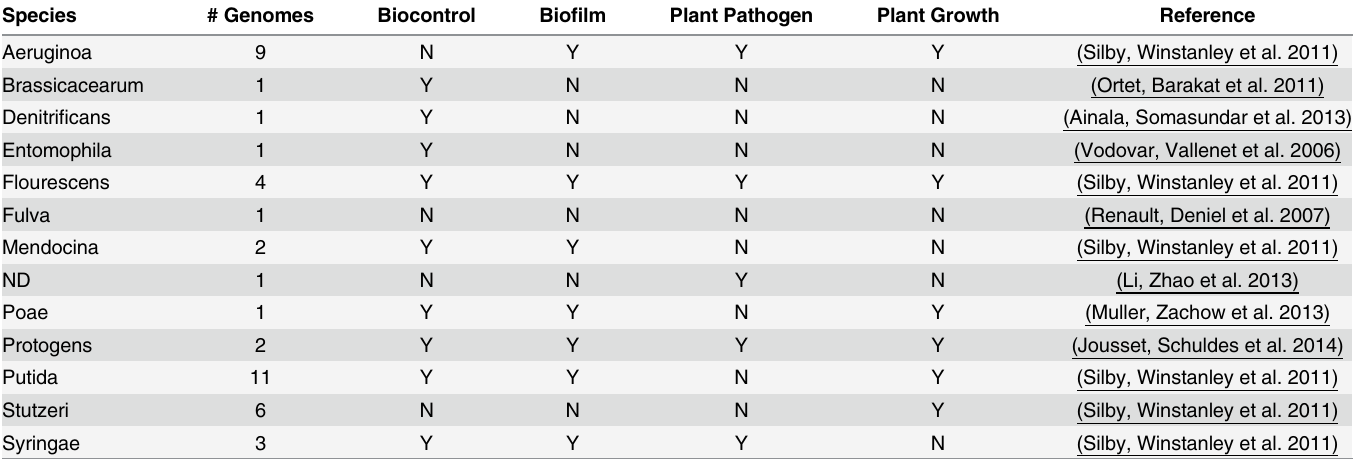
Table 1. Assigned Ecological Niche Classifications of Pseudomonad